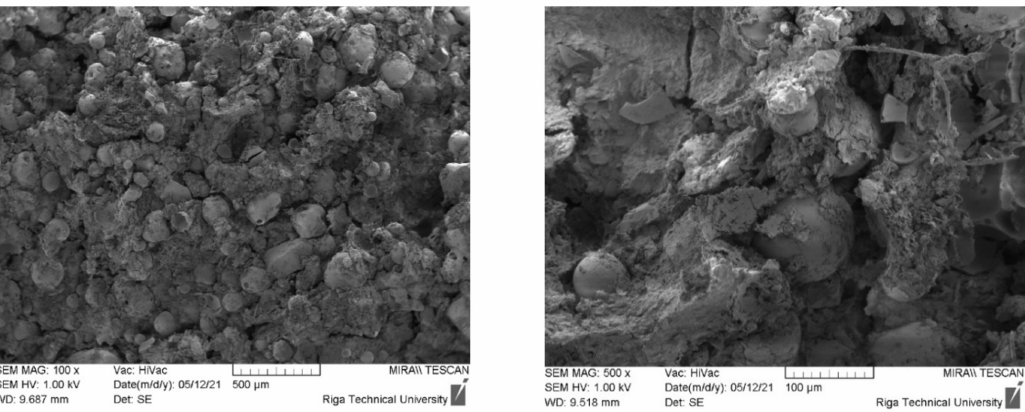
Figure 4. Sample images of samples 5-90-5 after destruction taken under × 100 and × 500 magnification.